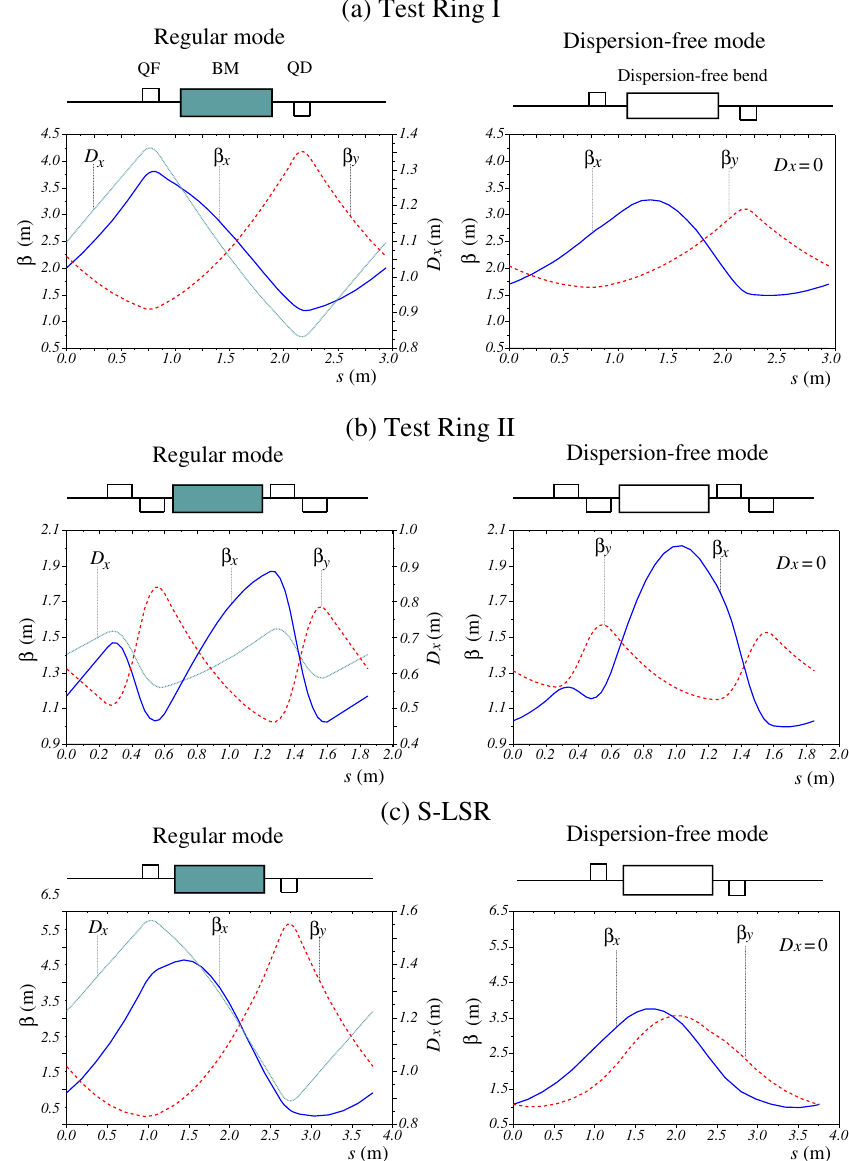
FIG. 1. Lattice functions of three storage rings in the regular operating mode and in the dispersion-free mode. The betatron functions (cid:5) and the dispersion function D across a unit cell have been displayed. In the dispersion-free mode, electrostatic deflectors are x (cid:3) y (cid:4) x turned on in all bending regions. The bare betatron tunes have been adjusted at the same numbers in both modes: (cid:3) (cid:6) (cid:3) 2 : 23 ; 2 : 23 (cid:4) for Test Ring I and Test Ring II, and (cid:3) (cid:6) (cid:4) (cid:2) (cid:3) 2 : 07 ; 2 : 07 (cid:4) for S-LSR. Other parameters are summarized in Table ; (cid:6) x y